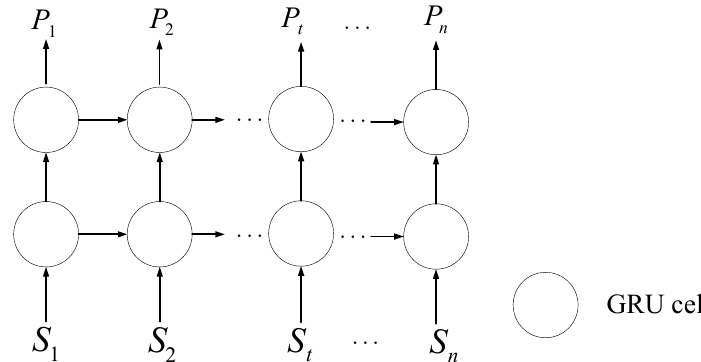
Figure 5. The network structure of gated recurrent unit (GRU).